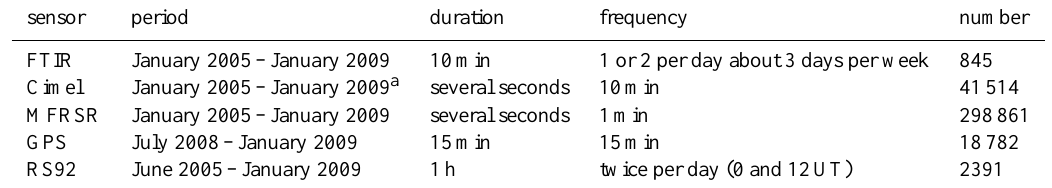
Table 2. Availability of PWV data from Iza˜na’s FTIR, Cimel, MFRSR, GPS, and RS92 experiments. Covered period, duration of a single measurement, measurement frequency, and total number of available measurements between 2005 and 2009.